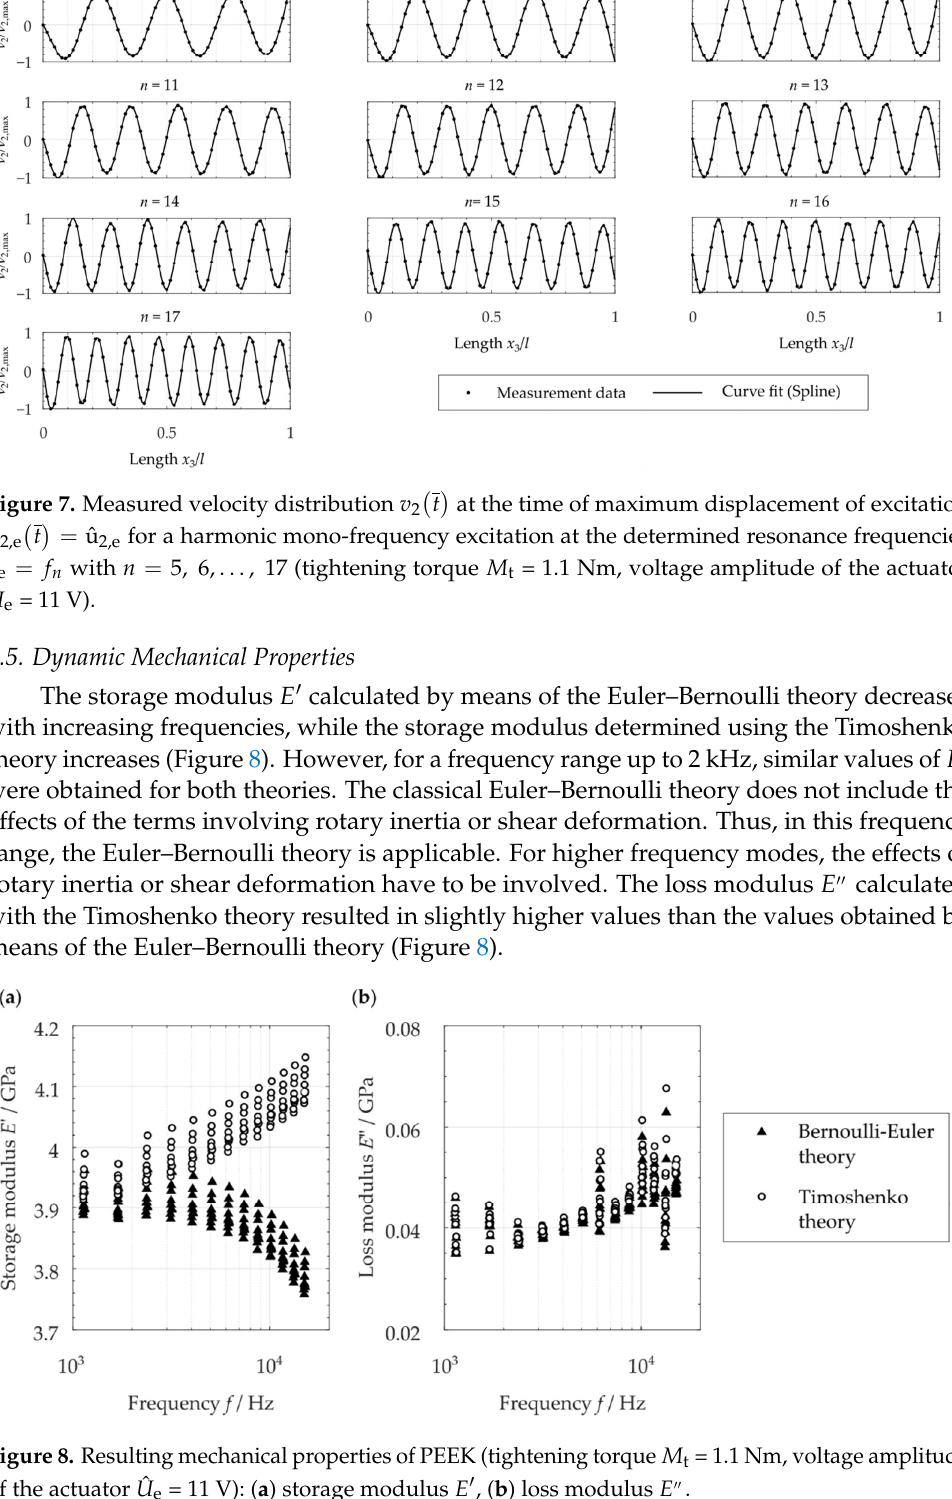
Figure 9. Frequency dependence of the mechanical loss factor tan𝛿 based on dynamic mechanical analysis (DMA) and the evaluation of the base-excited beam’s damping behavior. For the used test setup, large errors in the calculated properties can be a result of relatively small measurement errors. To minimize such systematic deviations, the meas- urement approach should be applied to well-damped viscoelastic materials only and the signal-to-noise ratio should not be very high. Thus, the displacement amplitude of the base excitation should not be chosen too small. The applicability of the used test configu- rations for anisotropic material polymeric materials, such as composites, has to be tested in further investigations. The evaluation of these materials requires a more in-depth ana- lytical description of the base-excited beam’s vibrations and its resulting vibration-damp- ing properties. However, using the test method illustrated in the current study enables the characterization of these materials, as well. 4. Conclusions The used test setup of a piezoelectrically driven base excitation of a polymeric speci- men and the non-contact velocity and temperature measurement reliably enables the measurement of the beam’s velocities, as well as its surface temperature. Evaluating the resonance frequencies and the 3 dB bandwidth, the viscoelastic properties of the polymer